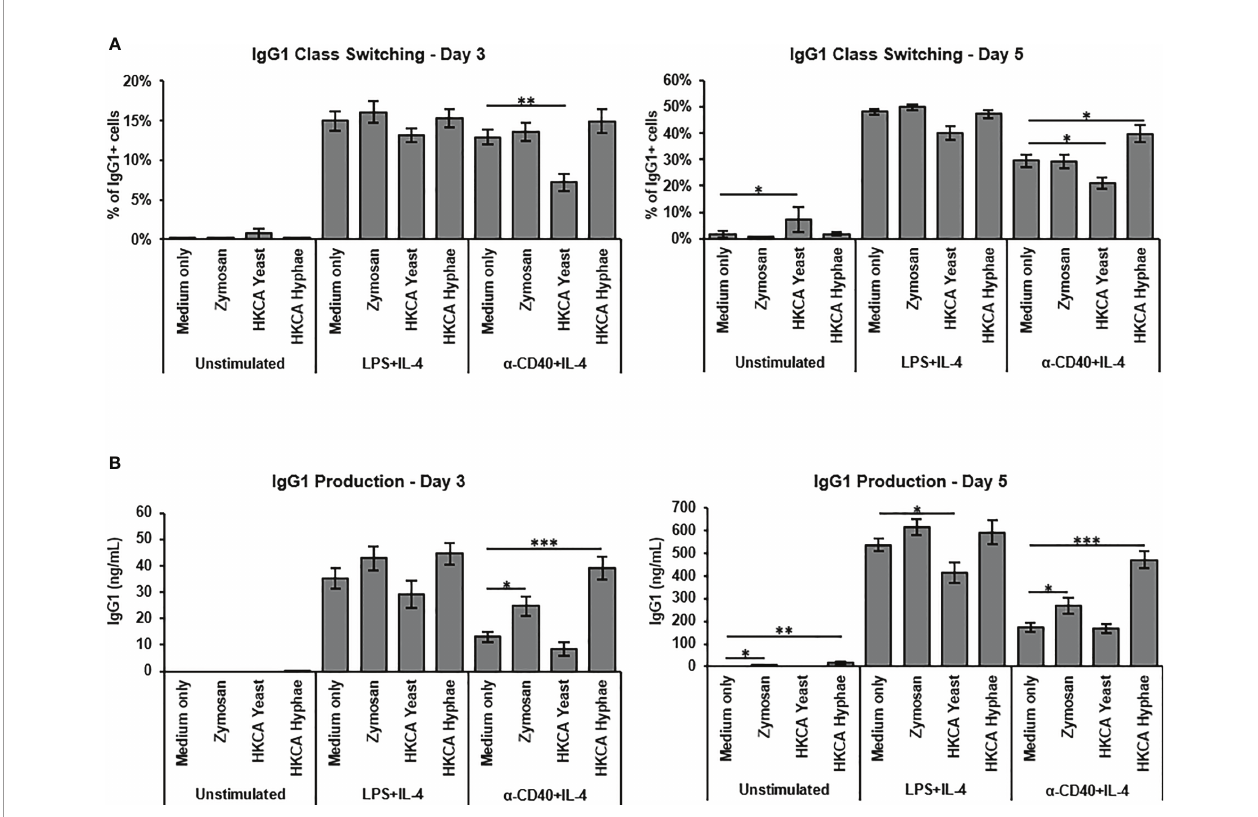
FIGURE 1 | B cell stimulation with Zymosan and HKCA hyphae leads to increased antibody production. Splenic mouse B cells were cultured either unstimulated or stimulated with LPS+IL-4 or anti-CD40+IL-4 in the presence of Zymosan, HKCA yeast or HKCA hyphae. (A) IgG1 class switching. Percentage of IgG1-positive cells among live B cells was measured by fl ow cytometry after 3 and 5 days of culture. For representative plots and gating strategy see Supplementary Figure S1C . (B) IgG1 production. The concentration of secreted IgG1 in cell culture supernatants was measured after 3 and 5 days of culture by ELISA. Data represent mean ± Standard error of the mean (SEM) of 10 mice, with triplicate measurements performed for each mouse. *p < 0.05, **p < 0.005, ***p <